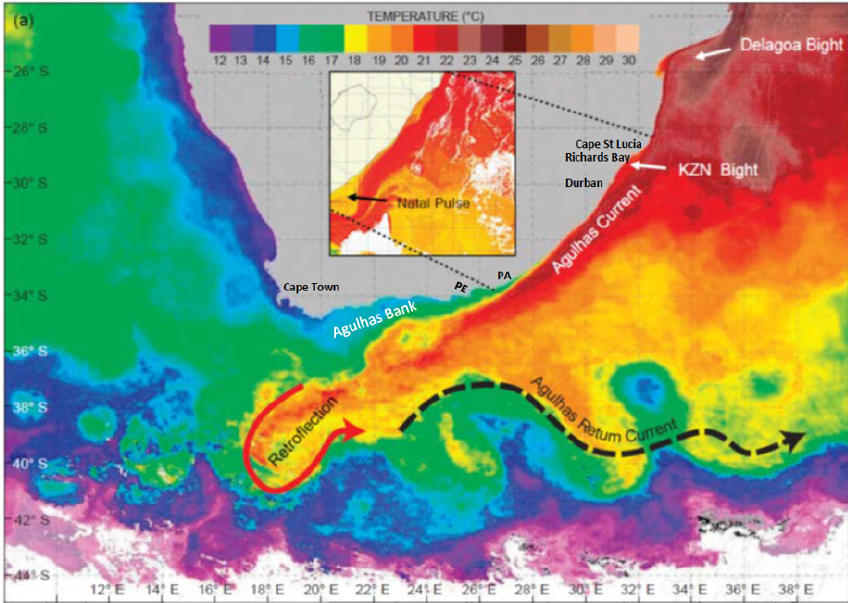
Figure 2. SST image highlighting the Agulhas Current flowing along the east coast of South Africa. PE is Port Elizabeth; PA is Port Alfred. Insert highlights a southwestward-propagating Natal pulse (a singular meander in the trajectory) which has a cold core. The shelf on the east coast is narrow with a steep continental slope. Exceptions are the KwaZulu-Natal (KZN) Bight and the Agulhas